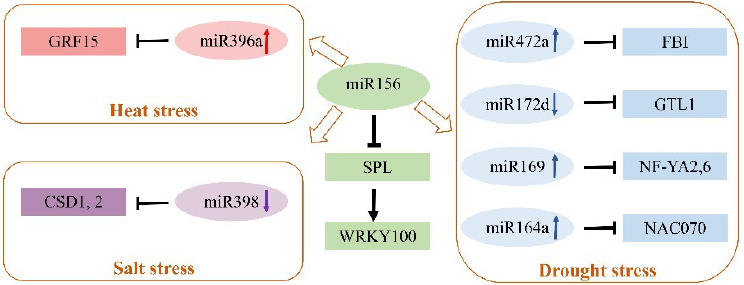
Figure 3. The regulatory network of miR156 for other miRNAs in forest trees in response to abiotic stress [24–26,35,52,85–87]. miR156 downregulates SPL , and the miR156/SPL module regulates salt stress tolerance in apple by activating WERKY100 expression. Overexpression of miR156 upregulates miR472a, miR169, miR164a, and miR396a, while it downregulates miR172d and miR398 in poplar. miR396a mediates the response of heat stress via targeting GRF15 in poplar. miR398 mediates the response of salt stress via targeting copper/zinc superoxide dismutase ( CDS1 , 2 ) in grapevines. miR169o plays a positive role in regulating drought tolerance and growth by targeting the subunit A of the Nuclear Factor Y ( NF - YA6 ) gene in poplar. miR172d regulates the drought stress response via targeting the GT-2-like 1 ( GTL1 ) trihelix transcription factor in poplar. miR472a mediates the drought stress response via targeting F-box 1 ( FB1 ) in poplar. miR164a mediates the drought stress response via targeting NAC (NAM, ATAF, and CUC) in poplar. Note: the brown arrows show miR156 indirectly mediates abiotic stress by regulating other miRNAs in forest trees. The black arrows show positive regulation and the black blocked arrows show negative regulation. The upward arrows behind miRNAs represent upregulated expression of miRNAs, the downward arrows behind miRNAs represent downregulated expression of miRNAs, and the rectangular box shows the target genes of